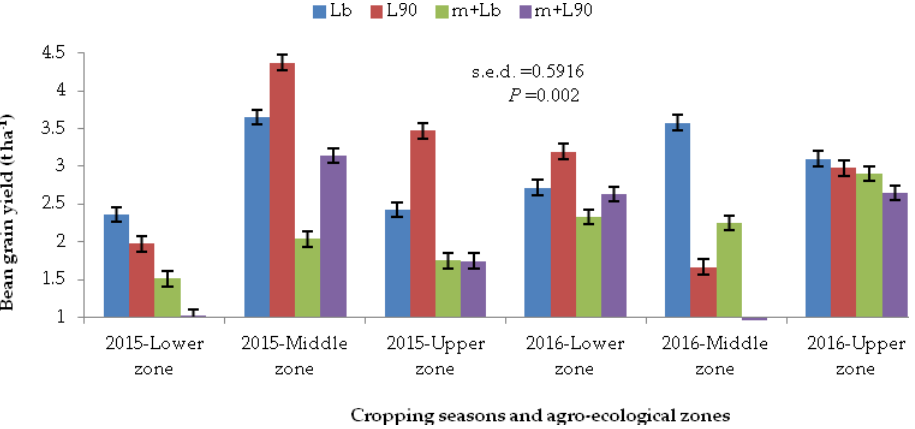
Figure 3. Bean grain yield as significantly affected by the interactions of cropping seasons × agro-ecologies × cropping systems. Key: Lb = monoculture local bean, L90 = monoculture improved bean, m + Lb = intercropped local bean with maize, m + L90 = intercropped improved bean with maize, s.e.d. = standard errors of differences of means.